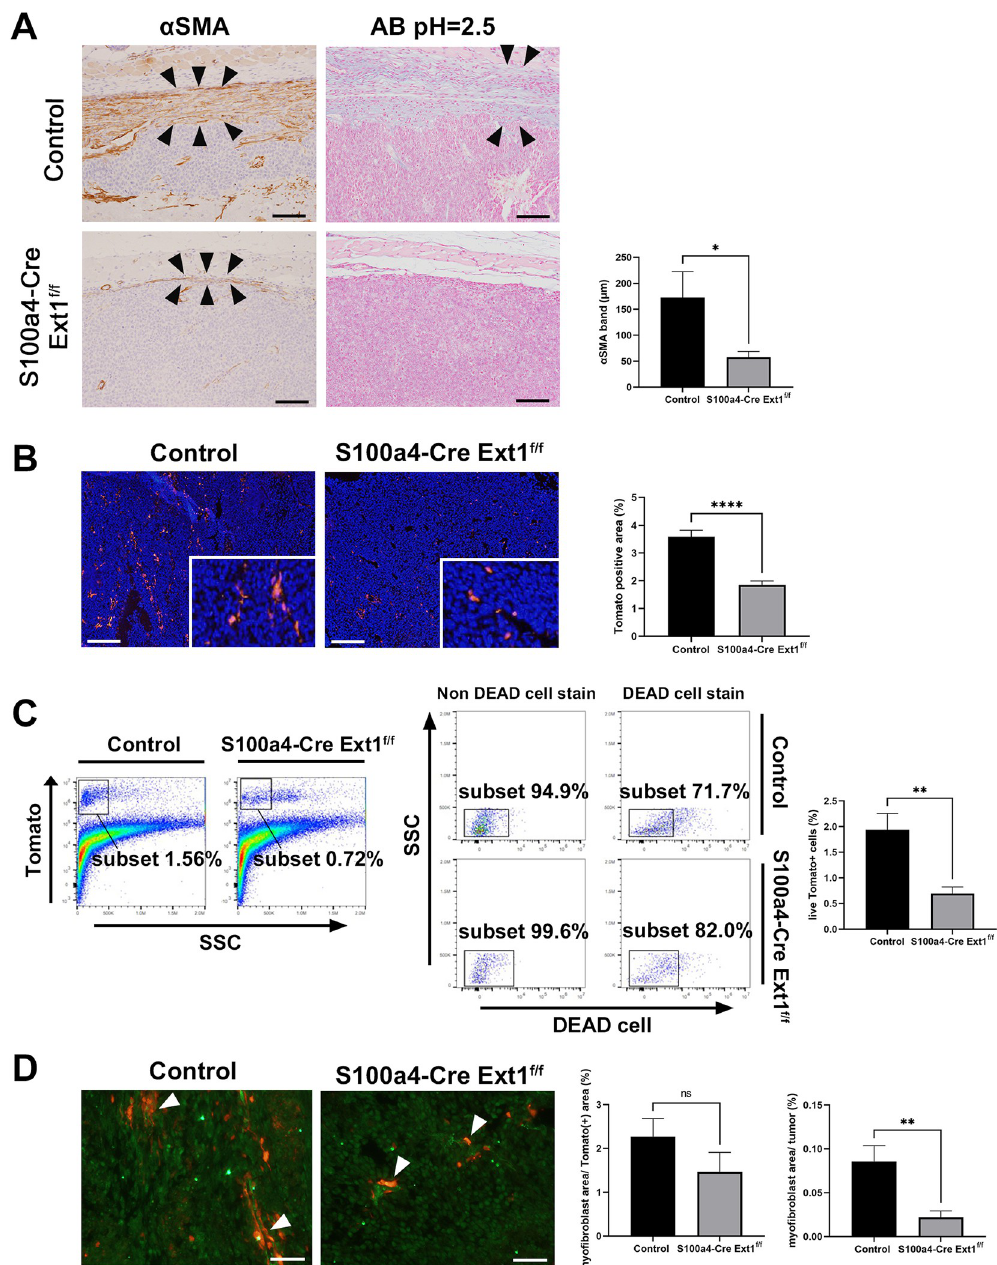
Fig 3. Decreased peritumoral myofibroblasts in the MC38 S.C. tumors of S100a4-Cre; Ext1 f/f mice. (A) Immunostaining of α -smooth muscle actin ( α SMA)-positive spindle cells, i.e., myofibroblasts, in the peritumoral region of MC38 S.C. colon tumors in S100a4-Cre; Ext1 f/f and control mice (left). Arrowheads indicate the band comprising α SMA-positive cells. Alcian blue staining (pH = 2.5) in the peri-tumor region of MC38 S.C. colon tumors in S100a4-Cre; Ext1 f/f and control mice (middle). Arrowheads indicate the Alcian blue positive area. Measurement of the thickness of myofibroblasts around the MC38 S.C. tumor of S100a4-Cre; Ext1 f/f and control mice (right). Data represent mean ± SEM (N = 6 for each cohort, unpaired t-test, � P < 0.05). Scale bar = 100 μ m. (B) Tomato expression in the intra-tumor region of MC38 S.C. tumors of S100a4-Cre; Ext1 f/f ; Lsl-tdTomato and control ( S100a4-Cre; Lsl-tdTomato ) mice. Measurement of the area of Tomato- positive cells in both cohorts. Data represent mean ± SEM. N = 6 for each cohort unpaired t-test ( � P < 0.05, �� P < 0.01, ��� P < 0.001, ���� P < 0.0001). Scale bar = 100 μ m. (C) Flow cytometric properties of intra-tumor region of MC38 S.C. tumor in S100a4-Cre; Ext1 f/f ; Lsl-tdTomato , and control ( S100a4-Cre; Lsl-tdTomato) mice (representative data) (left). The subset represents tdTomato-positive fibroblast cells (left). Dead cell selection in flow cytometry (representative data) (middle). Only living tdTomato-positive cells are collected and analyzed (middle). SSC, side scatter. The ratio of the number